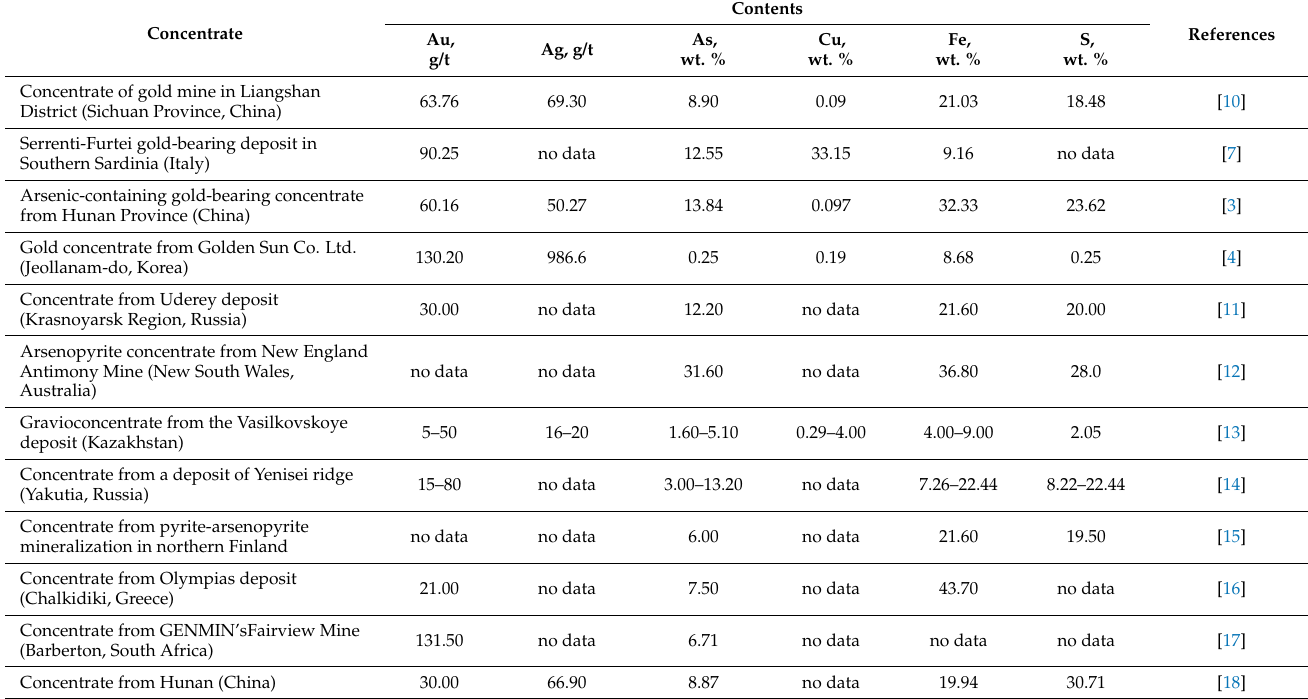
Table 1. Composition of gold- and arsenic-containing